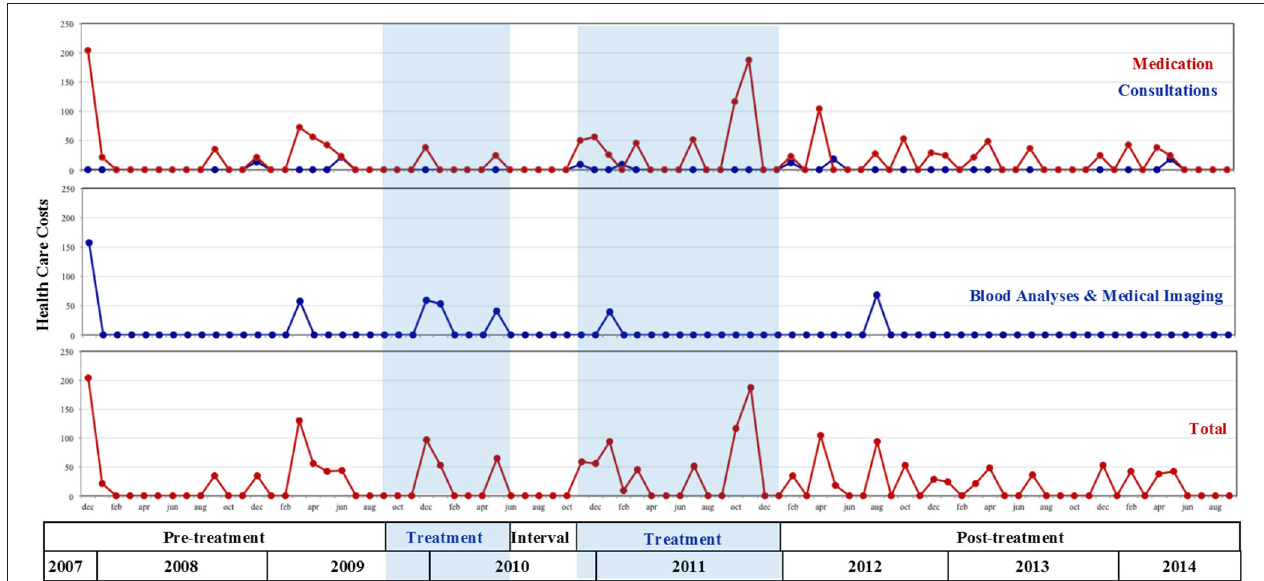
FIGURE 2 | Evolutions in patient’s health care costs (euro) from two years before onset of treatment until follow-up; Treatment was interrupted between sessions 19 and 20.